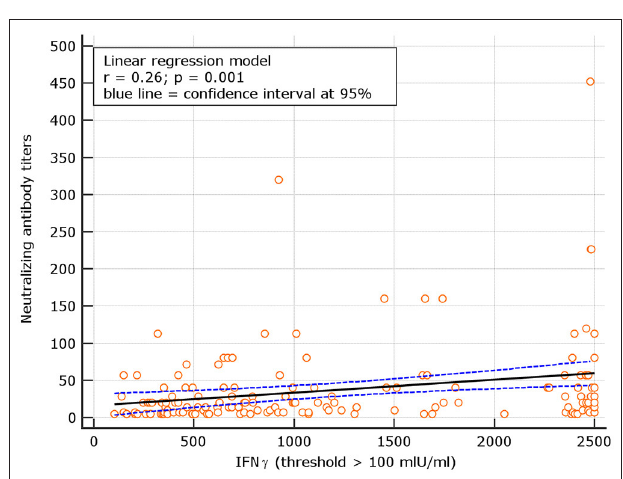
FIGURE 8 | Linear regression model between neutralizing antibody titers and IFN- γ concentration in naive (with IFN- γ threshold > 100